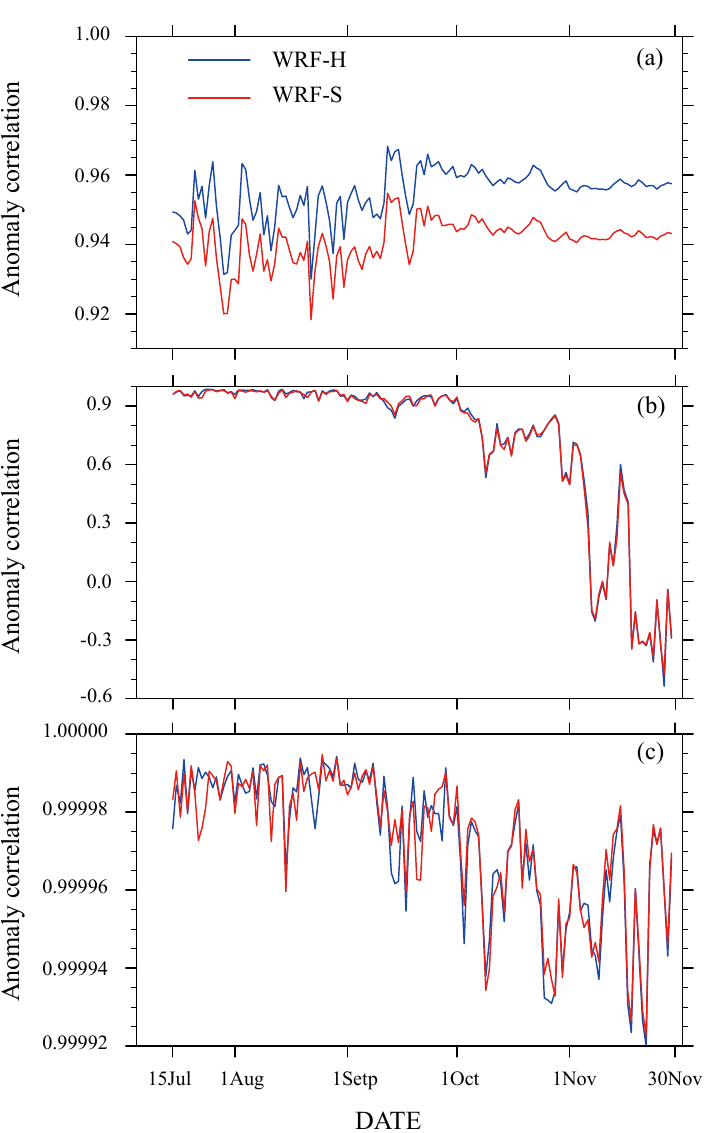
Figure 6. Anomaly correlation coefficients of ( a ) soil moisture against SMAP, ( b ) evapotranspiration against GLEAM, ( c ) air temperature at 2 m against CMFD.